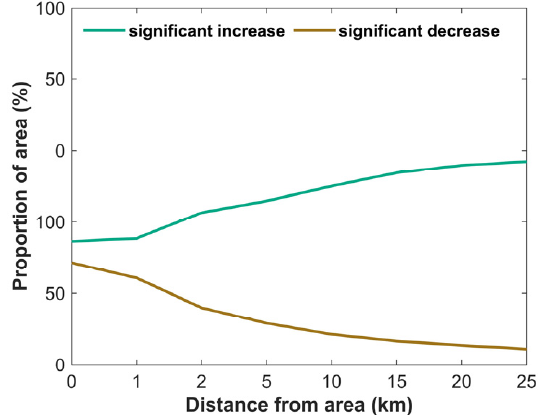
Figure 5. Pixel variations of significant increase and significant decrease across all the 35 cities ( p < 0.05).